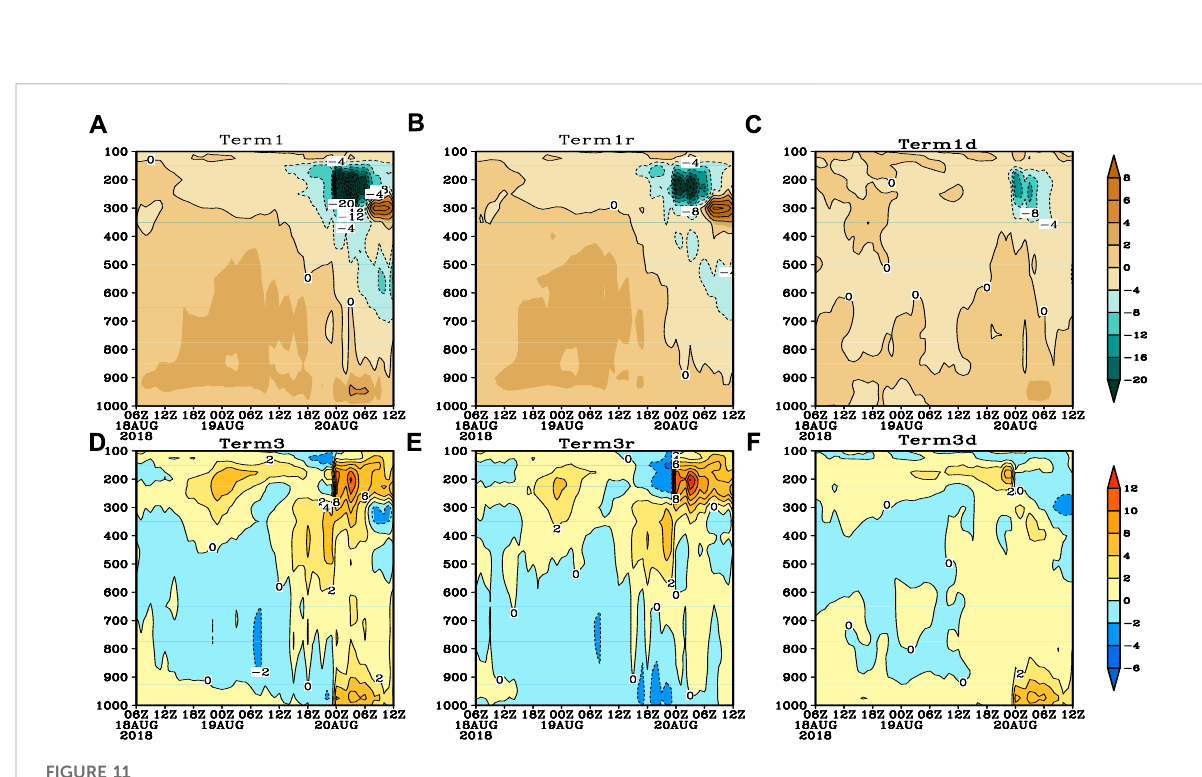
FIGURE 11 (A) T1, (B) T1r, (C) T1d, (D) T3, (E) T3r, and (F) T3d by the SOR method in the typhoon-following